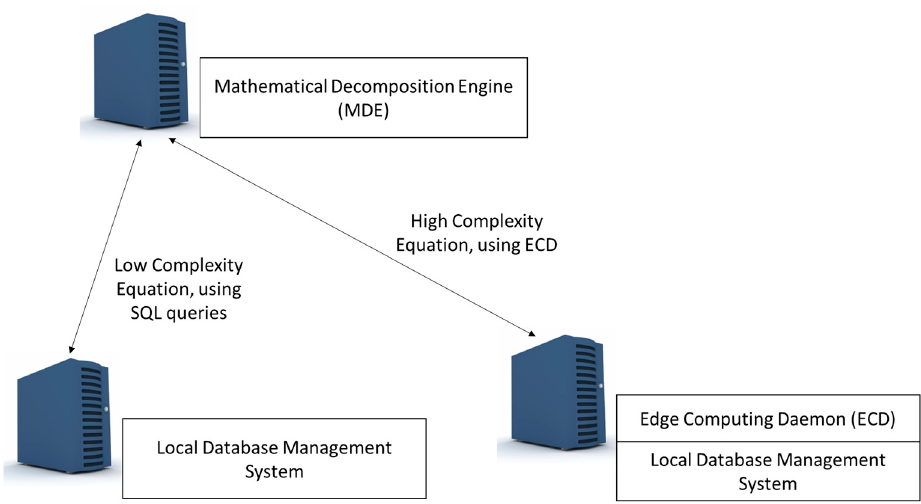
Figure 6. Overview of the ECD architecture.